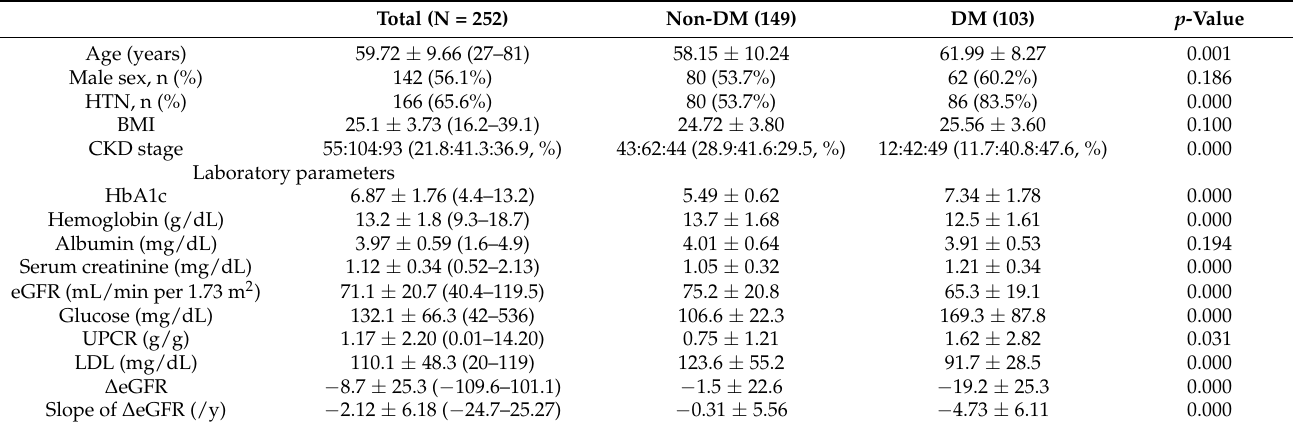
Table 2. Baseline characteristics of the study